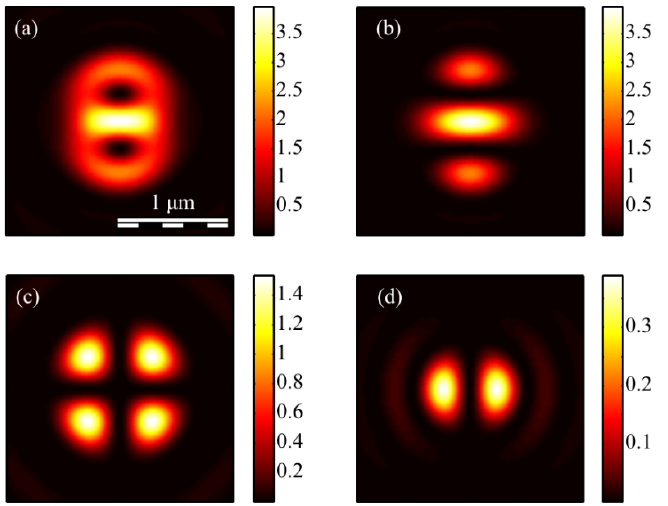
Figure 3. The intensity I ( a ) and its components I x ( b ), I y ( c ) I z ( d ) of the focused vector field (1) of the second ( m = 2) order with a = 1.